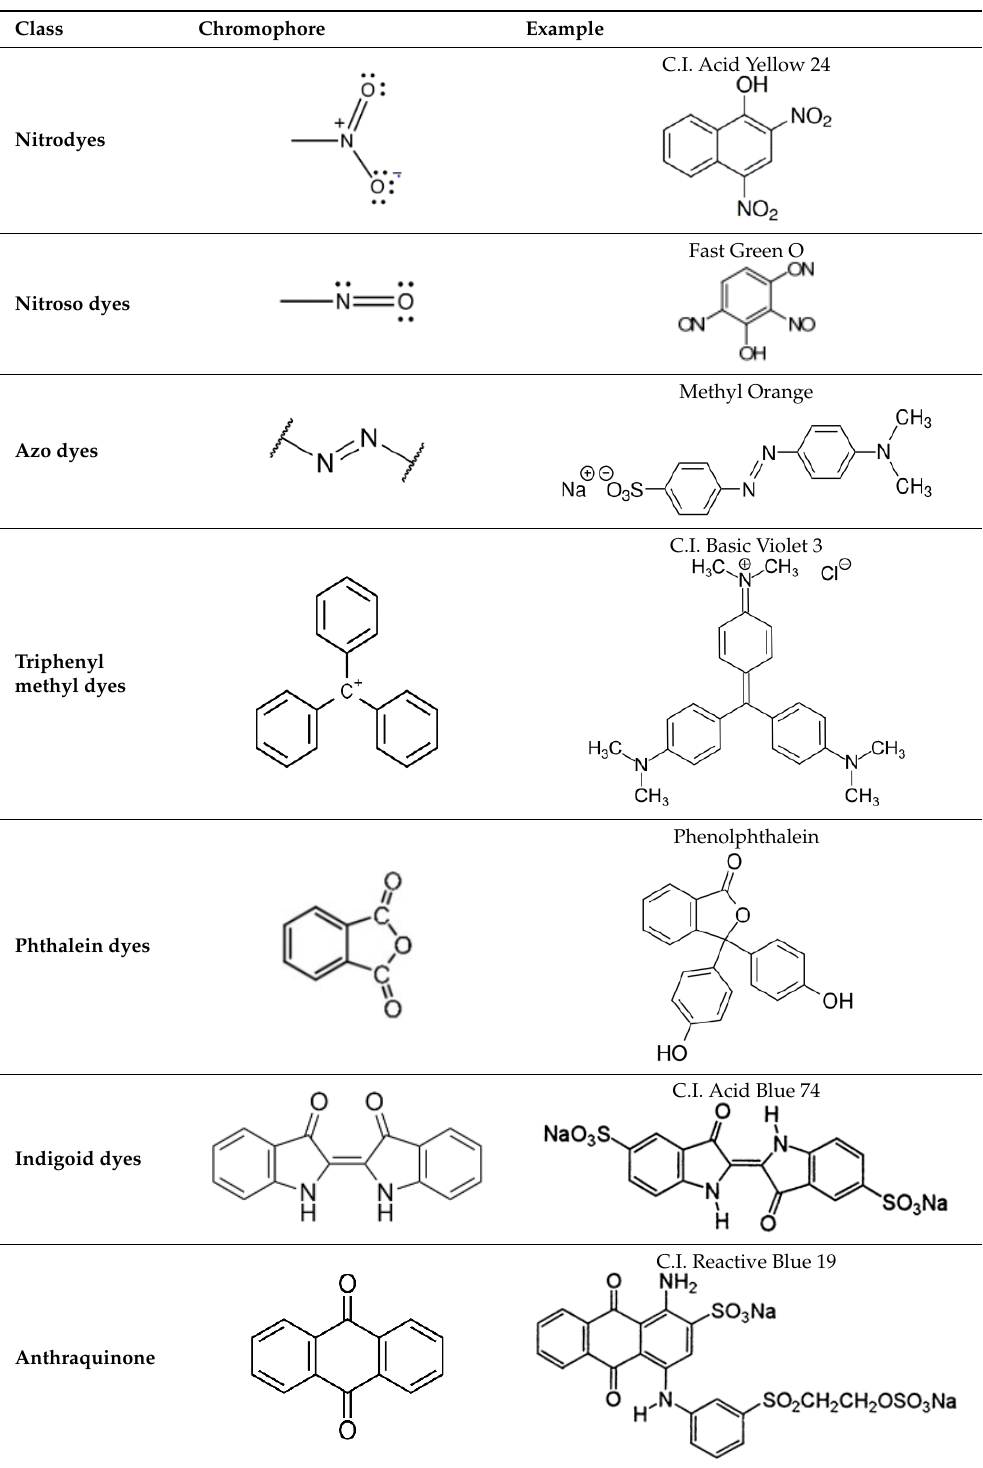
Table 1. Synthetic dyes: classification and examples of dyes according to the chromophore present.